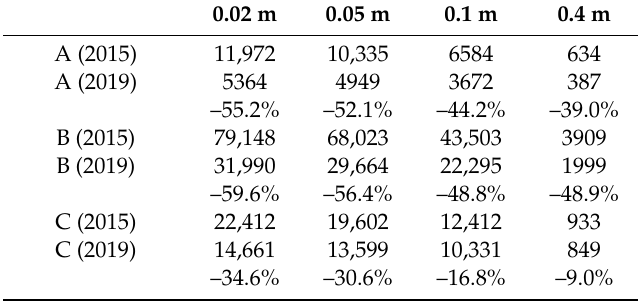
Table 2. The number of voxels that encompass occluding vegetation for the space between the road surface and the mounting height of the light sources in the 2015 and 2019 measurements. The numbers are presented for road segments A–E and cubic voxels with 0.02, 0.05, 0.1, and 0.4 m long edges. The lowest row cluster presents the average number of occluding vegetation among the road segments for voxel size. For each road segment (A–E) and their average, the relative decrease percentage in the number of occluding voxels is presented.